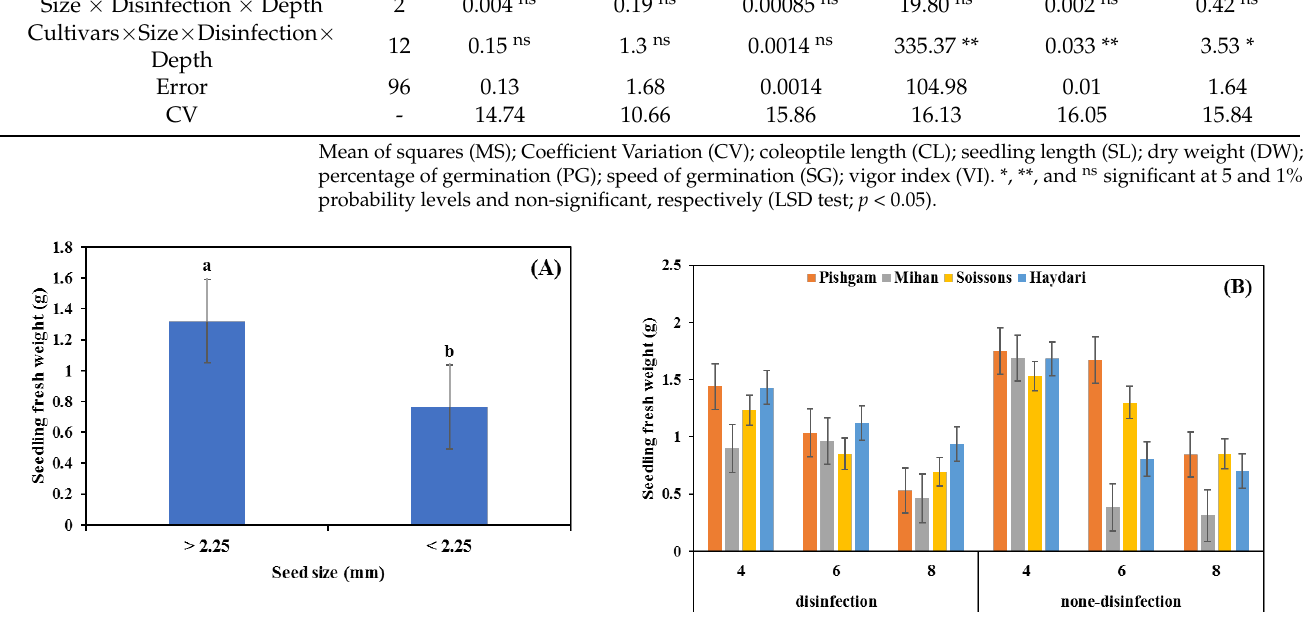
Figure 7. Effect of seed size ( A ), disinfection, cultivars, and depth of sowing ( B ) on seedling dry weight.The columns ’ letters indicate the differences between the different treatments ( p < 0.05) using the LSD test. The highest seedling length (14.1 ± 0.92 cm) was obtained in the Pishgam and Sois- sons cultivars, usinglarge seeds, and the lowest seedling length (9.57 ± 2.5 cm) was ob- tained in the Haydari and Mihan cultivars, using small seeds (Figure 8A). Furthermore, the results of comparisons of mean values related to the interaction of cultivar and sowing depth showed that the highest seedling length (14.62 ± 0.56 cm) was in the Soissons culti- var, at 4 cm depth, and the lowest seedling length (9.6 ± 0.38 cm) was also obtained in the seeds of theMihan cultivar soon, at a depth of 8 cm (Figure 8B).